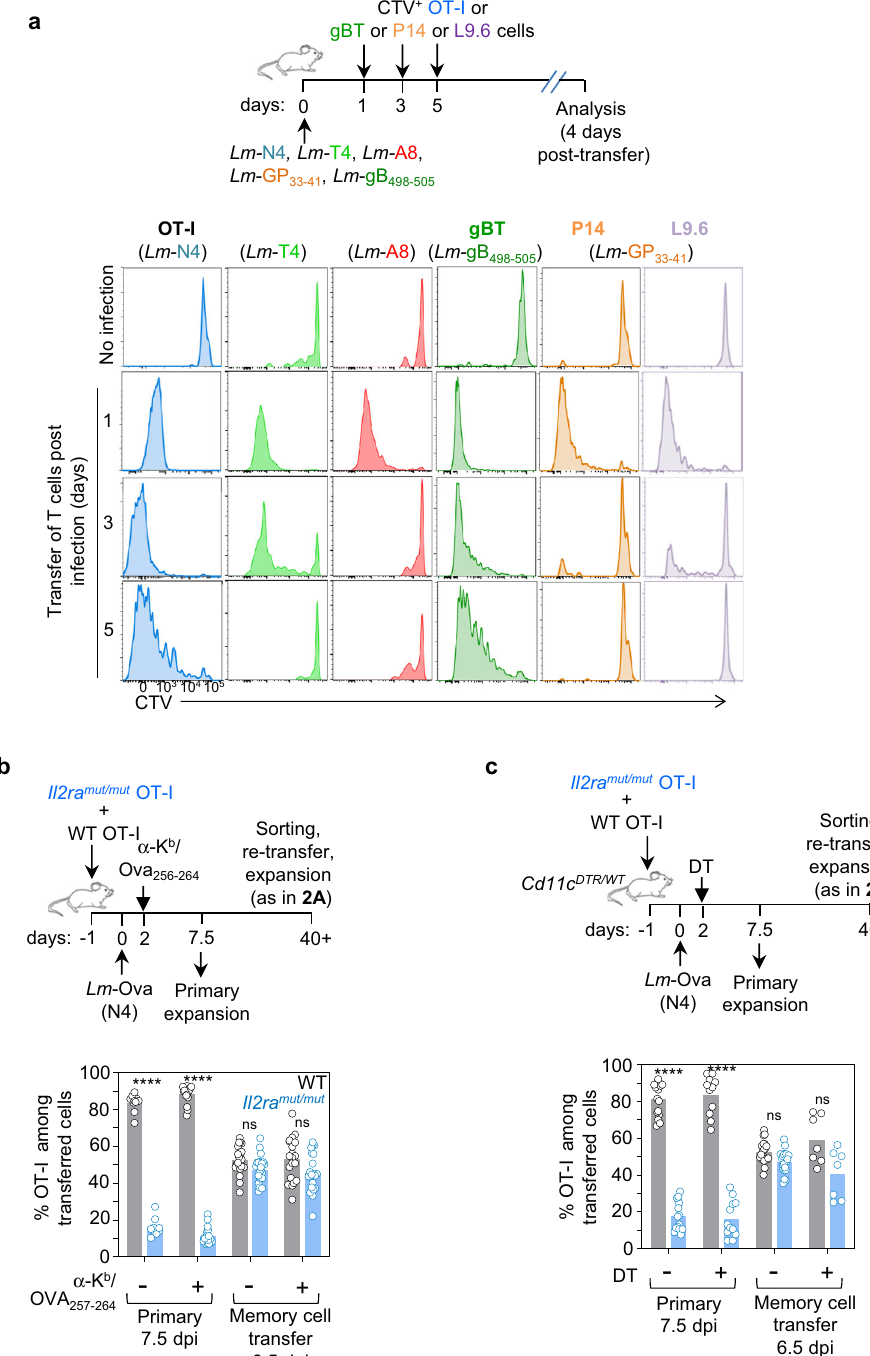
Fig. 4 The duration of cognate antigen presentation and the formation of functional memory CD8 + T cells are uncoupled. a WT mice were infected with indicated Lm strains. At speci fi ed times, OT-I, gBT, P14 or L9.6 cells were labeled ex vivo with CTV and adoptively transferred to previously infected hosts. Spleen cells were stained for FACS analysis 4 days later. Representative FACS histograms show the dilution of CTV staining in transferred T